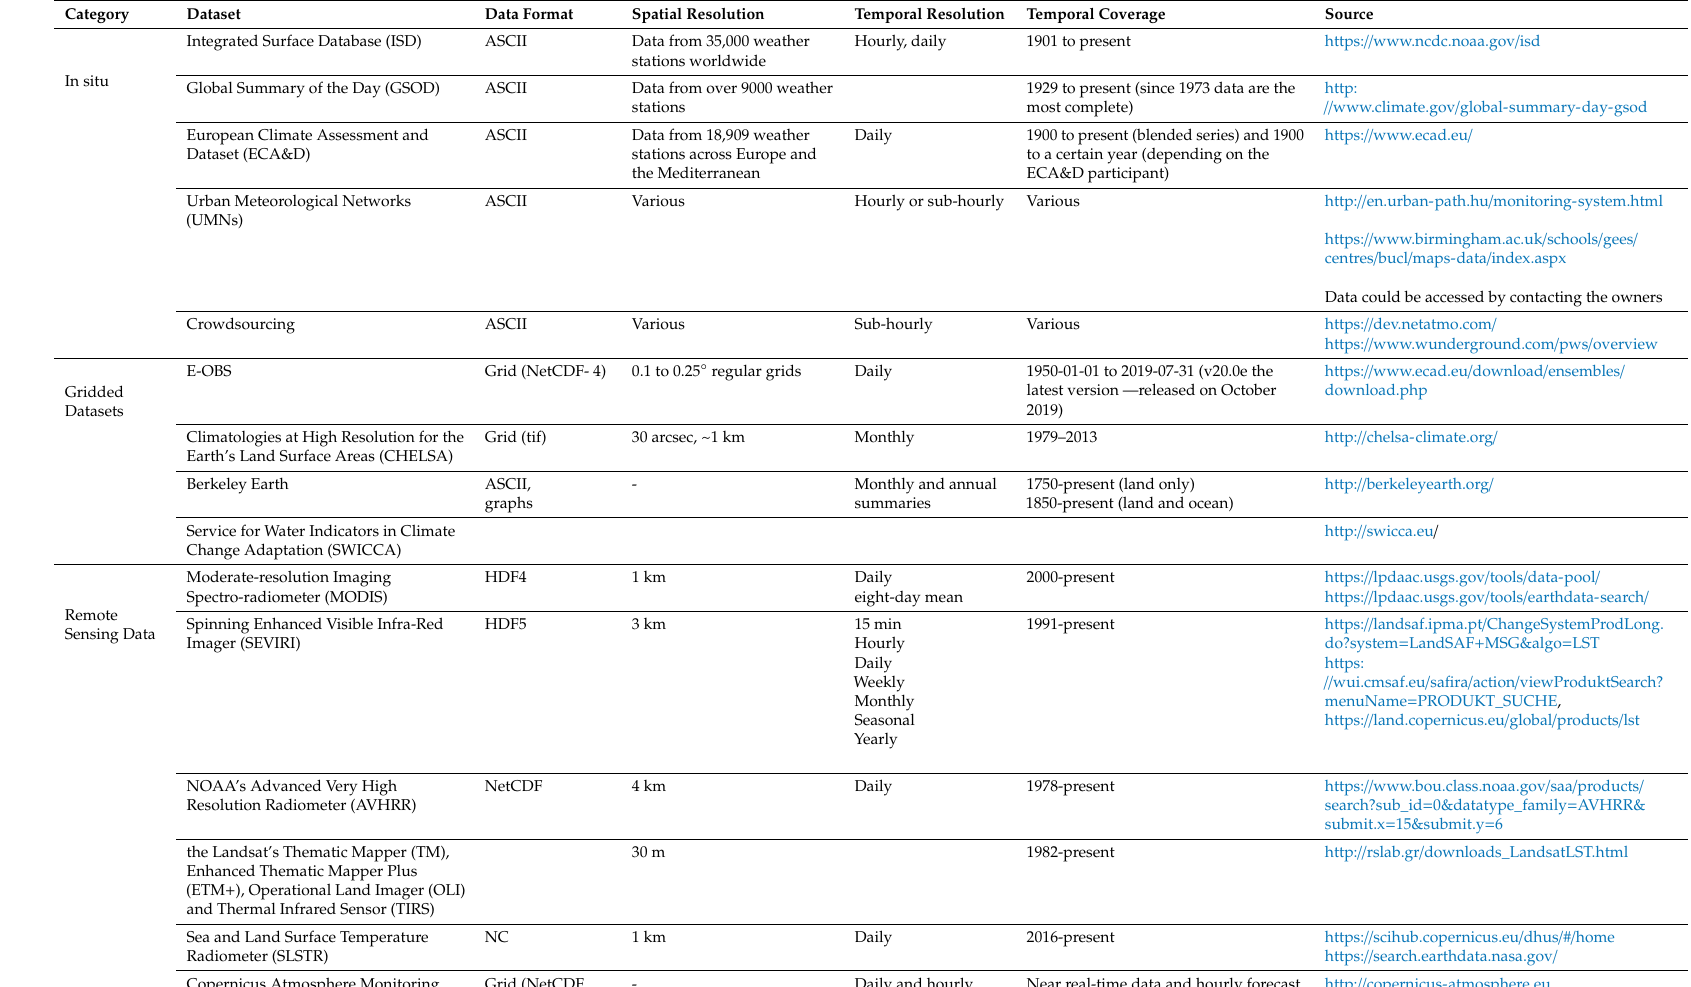
Table 2. Meteorological data sources for urban climate studies and